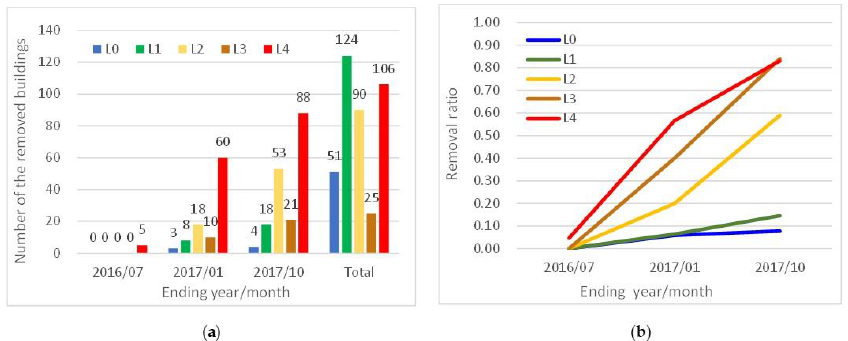
Figure 17. ( a ) The number of removed buildings at the end of the period (year/month) and the total number for each damage level. ( b ) The ratios of removed buildings at the end of the period (year/month) for each damage